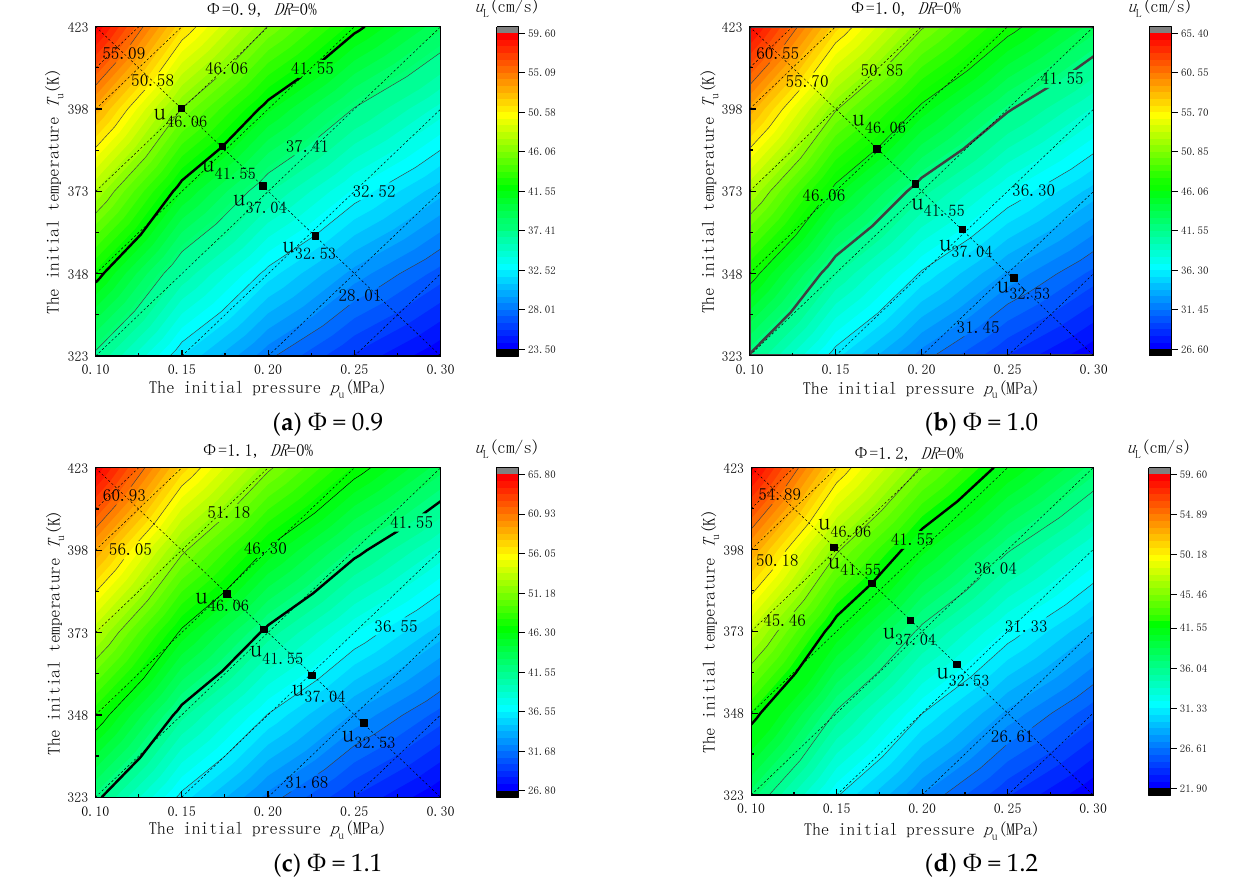
Figure 4. Equivalent distribution pattern of u L under the coupling effect of Tu and Pu when the equivalence ratios are 0.9, 1.0, 1.1 and 1.2 and when dilution rate (DR) is 0%.